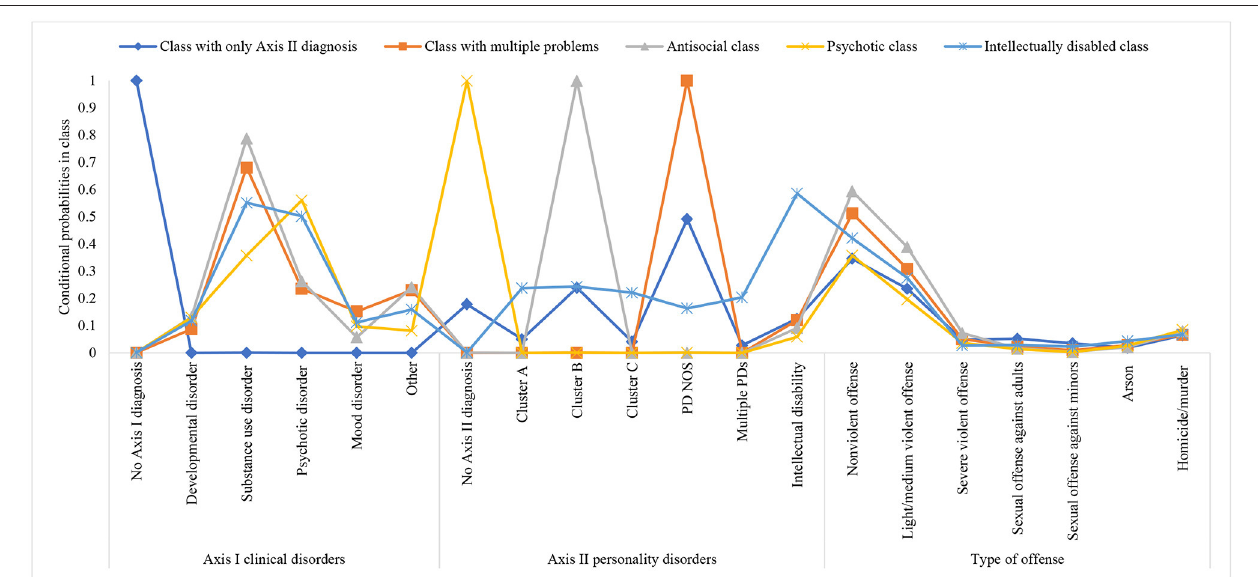
FIGURE 1 | Graphical representation of conditional probabilities by class. PD, personality disorder; NOS, not otherwise specified.